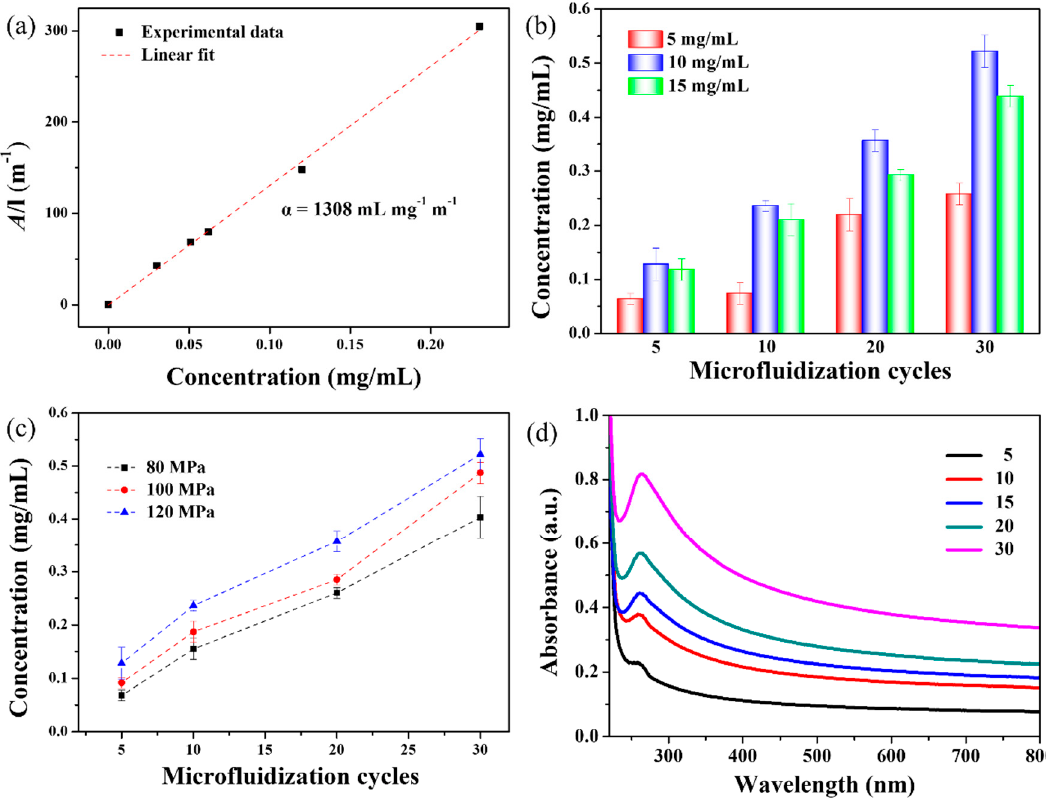
Figure 3. Correlation between UV-visible spectroscopy ( UV-Vis) absorbance and graphene concentration ( a ). Influence of the number of microfluidization cycles on graphene concentration in EG dispersions prepared using different amounts of SMA ( b ), and different pressures ( c ). UV-vis spectra of EG dispersions ( d ).